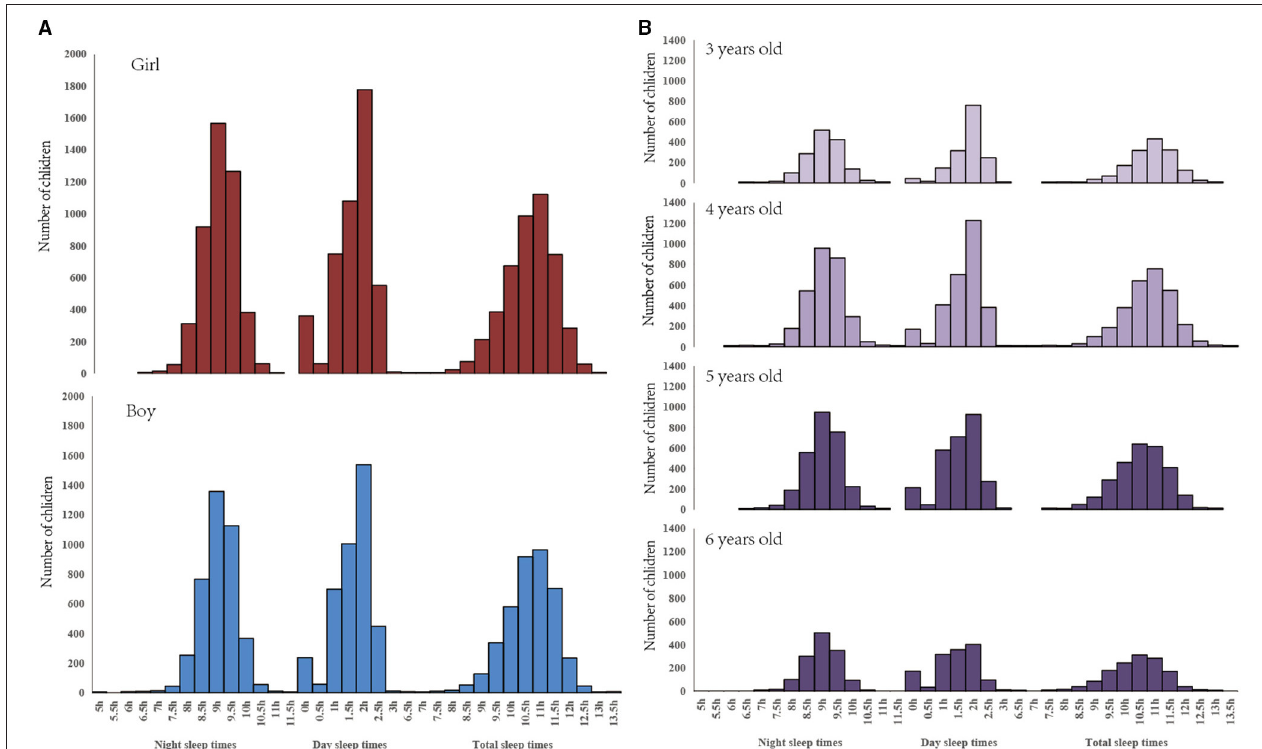
FIGURE 2 | The frequency distribution of the sleep duration of children in the daytime, night, and whole day between boys and girls and between children aged 3, 4, 5, and 6 years in the year 2018 in Shanghai, China. (A) Sleep times among children with different sex. (B) Sleep times among children with different